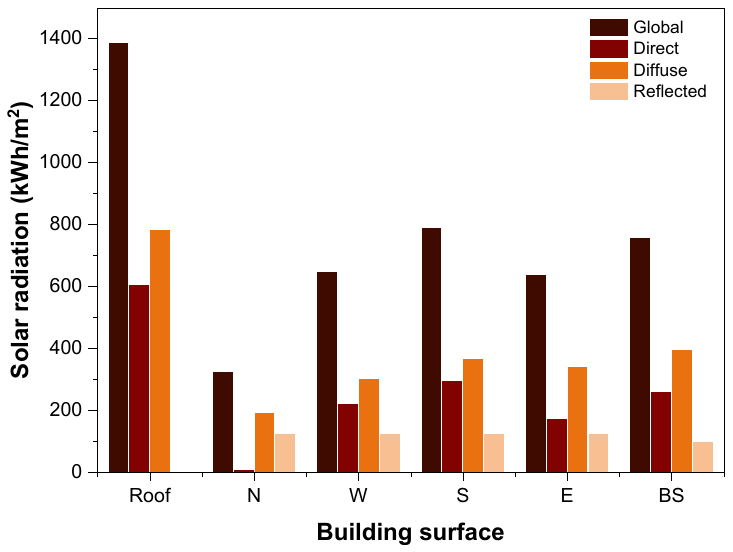
Figure 12. Annual incident solar radiation on building skins .